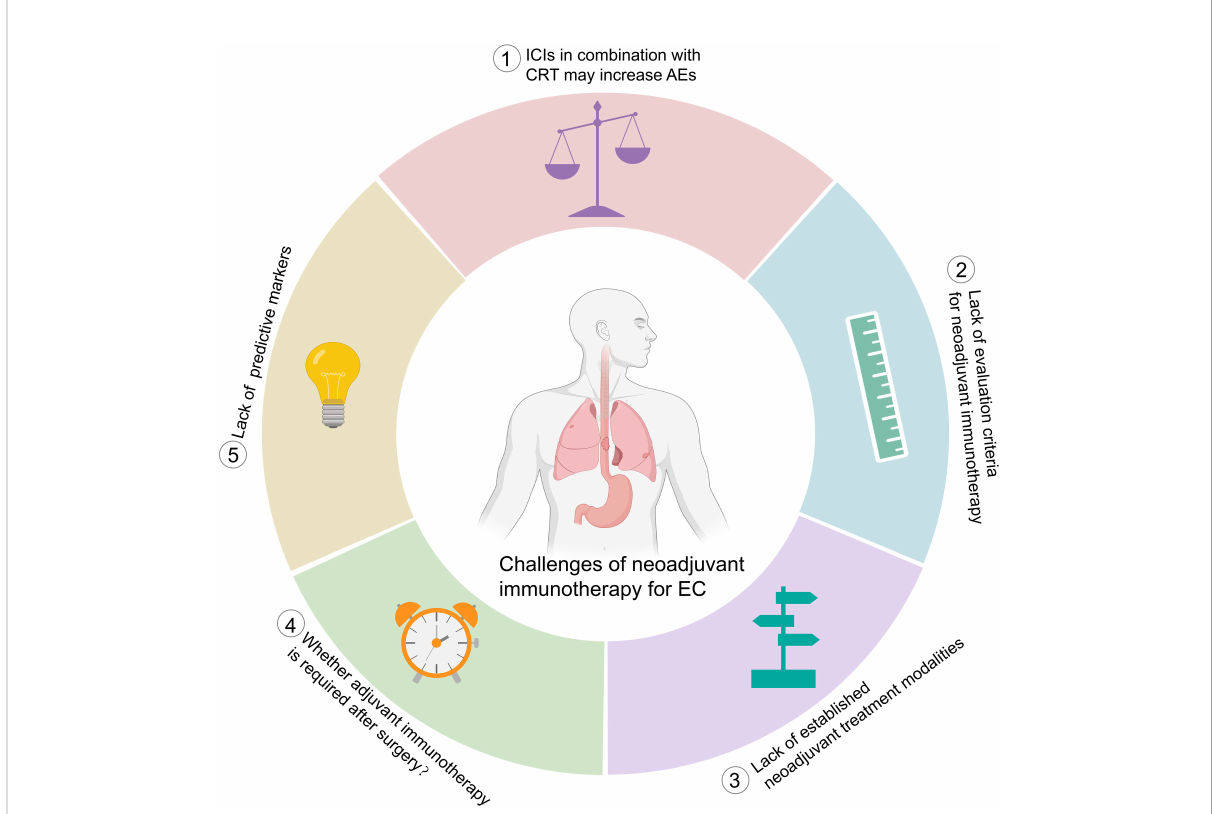
FIGURE 4 Challenges of neoadjuvant immunotherapy for esophageal cancer. ICIs, immune checkpoint inhibitors; CRT, chemoradiotherapy, AEs, adverse events; EC, esophageal